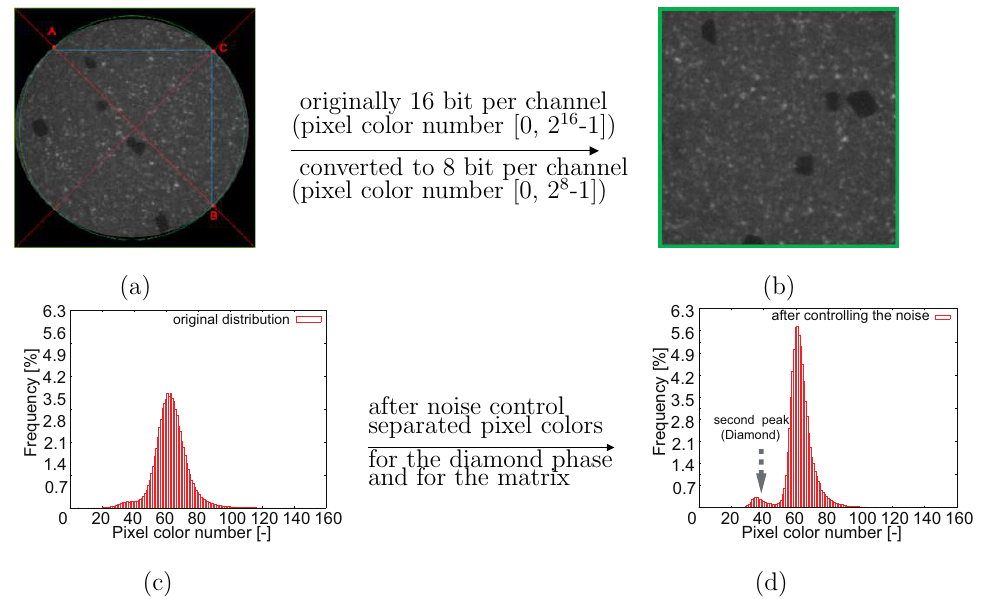
Figure 10. Tomographic image handling (scan-B, type-II quasi-brittle behavior): ( a ) extraction of a possible large square from each tomographic image with red-green-blue pixel color; ( b ) image with greyscale color; ( c ) noise exists in original images; ( d ) after noise control, pixel colors presenting diamonds separated from those presenting the matrix.